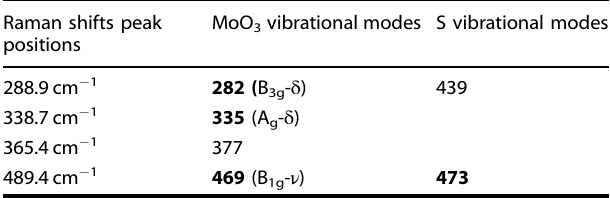
Fig. 3 Microstructure of the nanorods. a A bright fi eld cross-sectional TEM image indicating four regions. Scale bar 100 nm. b HRTEM image collected from region 4. Scale bar 10 nm. A corresponding FFT image is shown in the inset. Scale bar 10 1/nm. The EDS analysis shown in c reveal the chemical composition of the four regions. 1: SiO 2 region, 2: Mo thin fi lm region; including some oxygen content, 3: MoS 2 NSs region, 4: nanorod region, containing Mo and oxygen. Table 1. Raman shifts peak positions with respect to MoO 3 and S vibrational modes in the 250 – 500 cm − 1 frequency